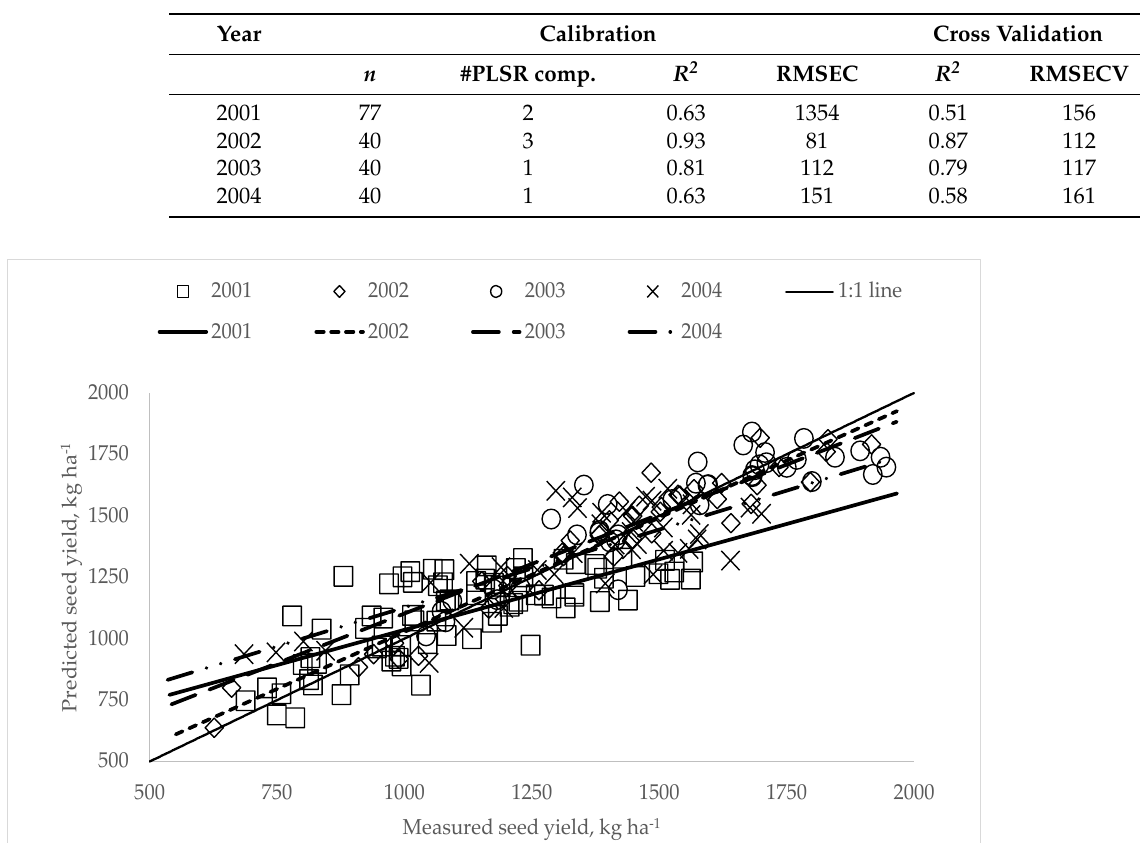
Table 6. Calibration and validation statistics of PLSR models on raw wavelengths and vegetation indices for determination of seed yield in 2001 to 2004. Units for RMSEC and RMSECV are kg seed ha − 1 .